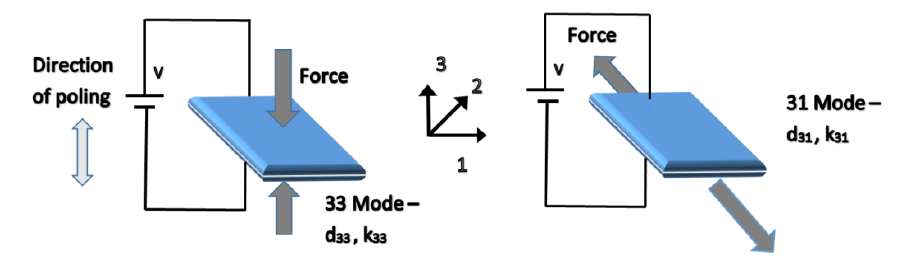
Figure 9. Piezoelectric constants in typical energy-harvesting modes [93].